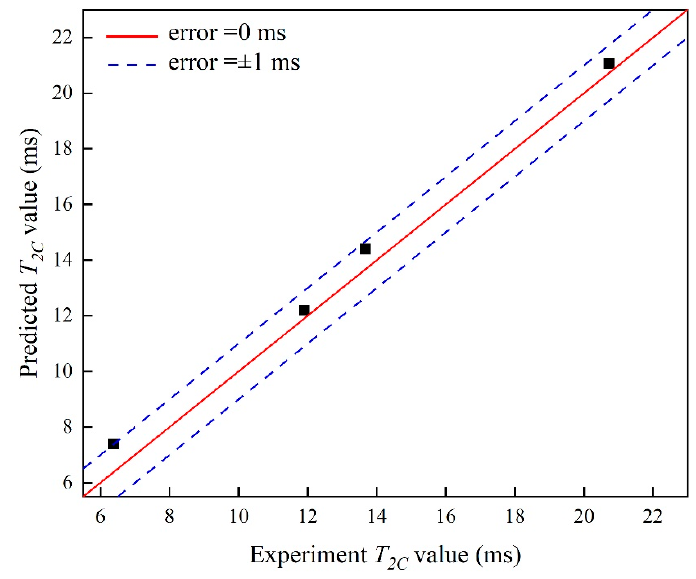
Figure 14. Cross-plot of experimental results and predicted results.